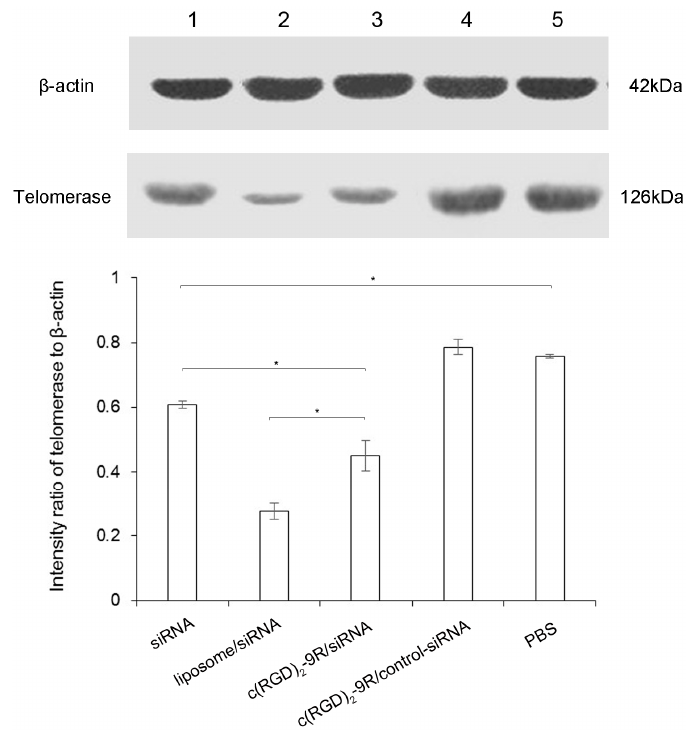
Figure 6. Western blot analysis of telomerase expression after transfection with different mixture: (1) naked siRNA only; (2) liposome/siRNA; (3) c(RGD) 2 -9R/siRNA; (4) c(RGD) 2 -9R/control-siRNA; (5) phosphate buffer saline (PBS) only. The band intensity ratios of telomerase to β -actin were also presented. * represents p < 0.05.